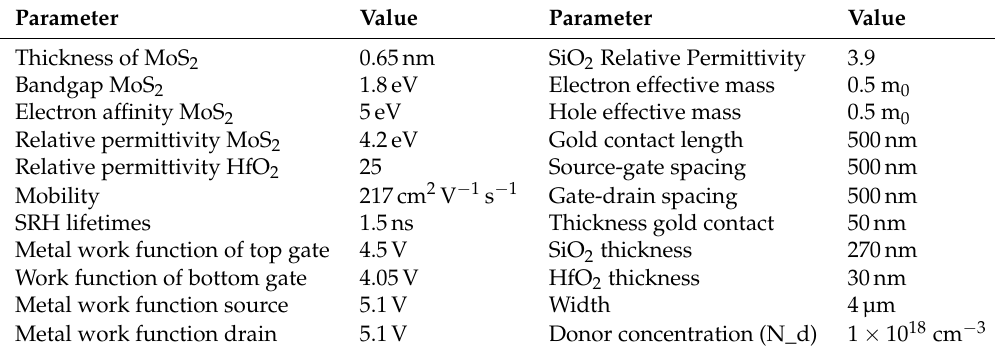
Table 2. Simulation parameters. All the data are taken from